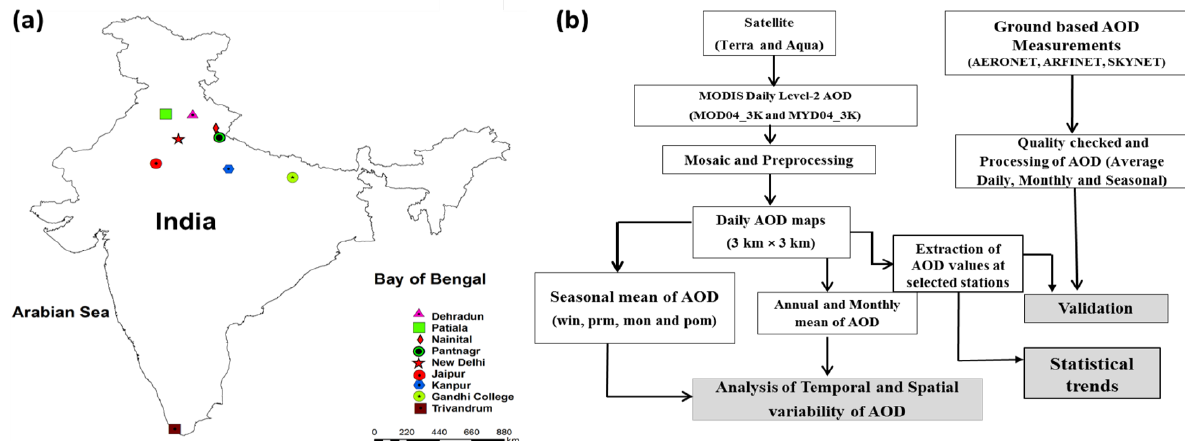
Figure 1. (a) Locations of ground based measurements and (b) Flowchart of methodology adapted in this study. we extracted AOD values at different geographical locations where the ground based measurements are available. Figure 1 shows the locations of ground based measurements and flowchart of methodology adopted in this study. The ground measurement data were averaged within 30 min of the satellite overpass time and compared with MODIS AOD averaged within a 3 × 3 pixel window of the measurement site. Monthly averages, correlations and their trends were obtained from MODIS and ground observations (AERONET, ARFINET, SKYRADNET) of all valid AOD values. For validation of MODIS AOD, we examined the statistical parameters such as